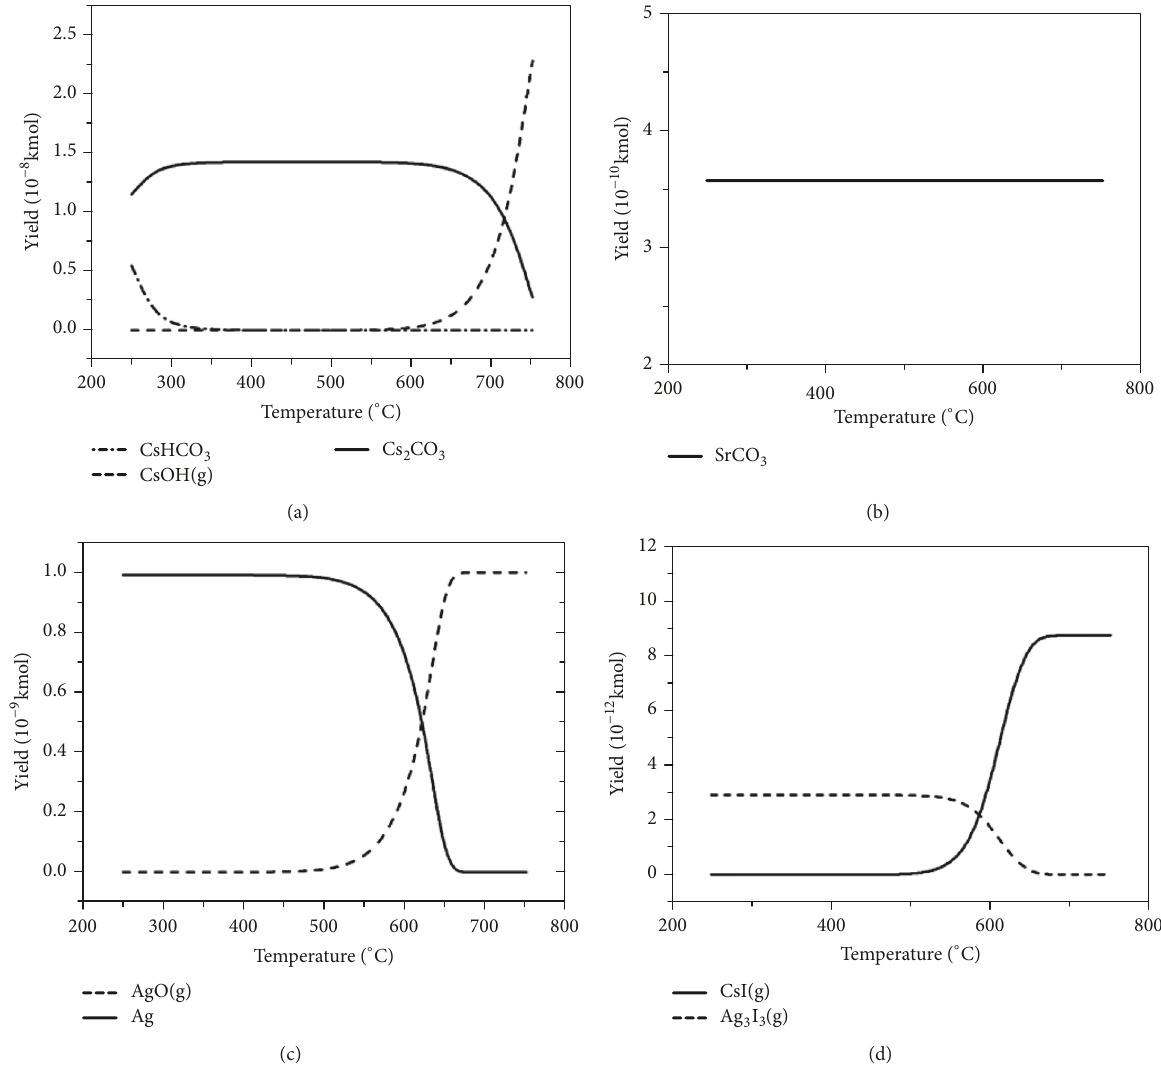
Figure 5: Variations in the chemical forms during an overpressure accident: (a) Cs, (b) Sr, (c) Ag, and (d) I.